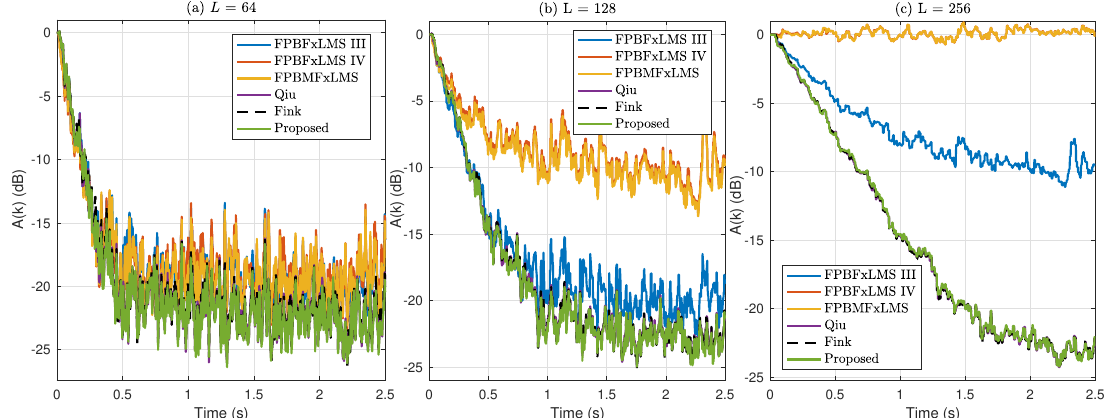
Figure 10. Learning curves of the frequency-domain ANC algorithms with narrow band noise as input. ( a ) L = 64. ( b ) L = 128. ( c ) L =